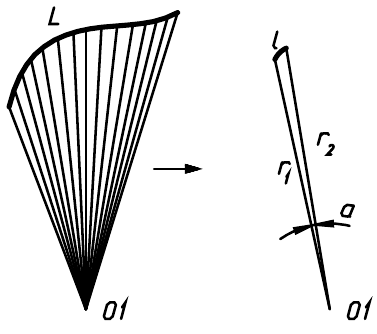
Figure 12. Roll line divided into segments.